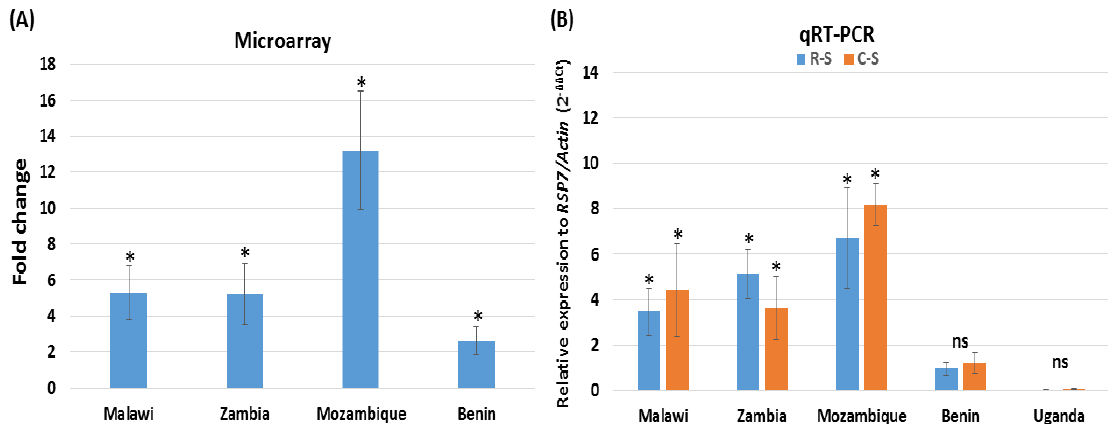
Figure 1. Transcription profile of CYP6AA1 across Africa. ( A ) Microarray -fold change of CYP6AA1 in four African countries using the 8x60k chip in comparison to the FANG (Funestus Angola) susceptible strain, from [13]; ( B ) quantitative reverse transcription polymerase chain reaction (qRT-PCR) expression of CYP6AA1 in five countries comparing the permethrin-resistant mosquitoes to the FANG susceptible (R-S) and the control unexposed to insecticides, to FANG (C-S). * Significantly different at p < 0.05. ns = not statistically significant.